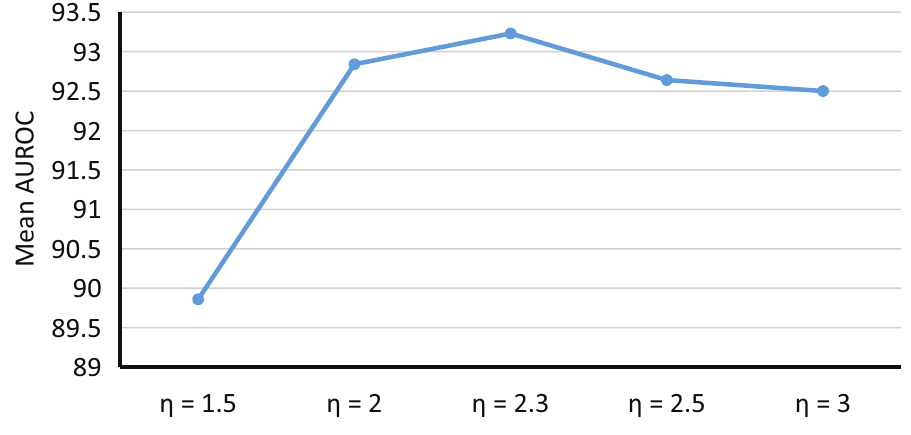
Figure 15. Effect of hyperparameter η on